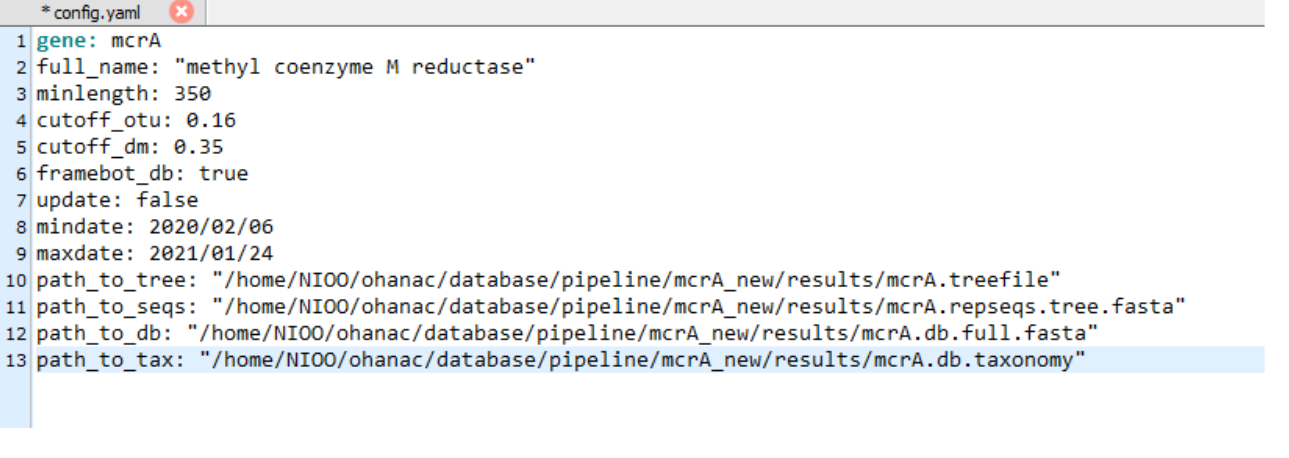
Figure 2. Configuration file with parameters defined by the user. Configuration file for the database producing pipeline, containing parameters for query search, minimum sequence size, OTU and distance matrix cutoff, and FrameBot database status. When the update parameter is set to true, the user also has to input the date range for the download of the new sequences and paths to the files of the database to be updated.